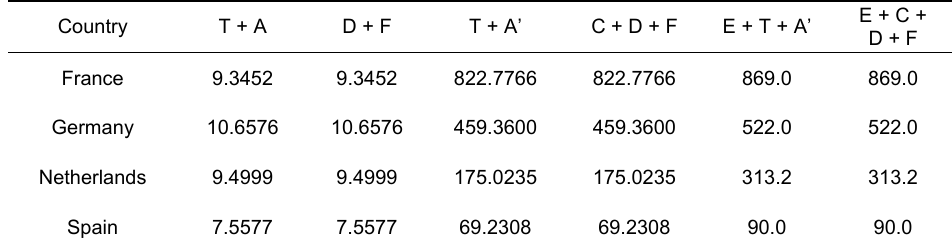
Table 4: Self-fnancing Programmes. Value of the Areas in Figure 2 by Countries Country T + A D + F T + A’ C + D + F E + T + A’